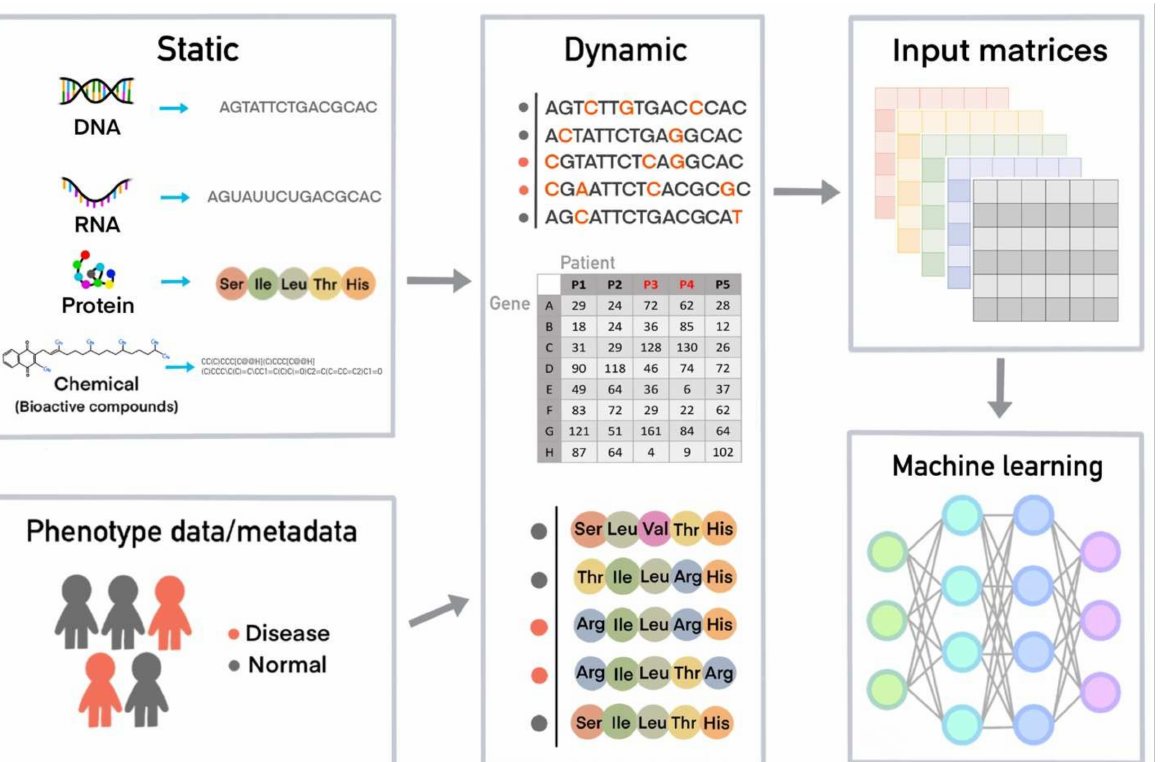
Figure 1. Various molecular and phenotypic data can be integrated to build a machine learning model. DNA, RNA, and protein, as well as chemical information, can be represented as strings ( top left ). This kind of fundamental molecular information can be defined as static information (deterministic), which shows little or no difference between individuals. On the other hand, phenotypic information (e.g., clinical data; bottom left ) and high-throughput screening data (e.g., RNA-seq) produce dynamic information of molecules that can be integrated and represented as matrices (e.g., rows represent features and columns indicate samples, or vice versa) ( middle ). A collection of properly labelled matrices ( top right ) is used as input data to build a machine learning model for a particular purpose ( bottom right